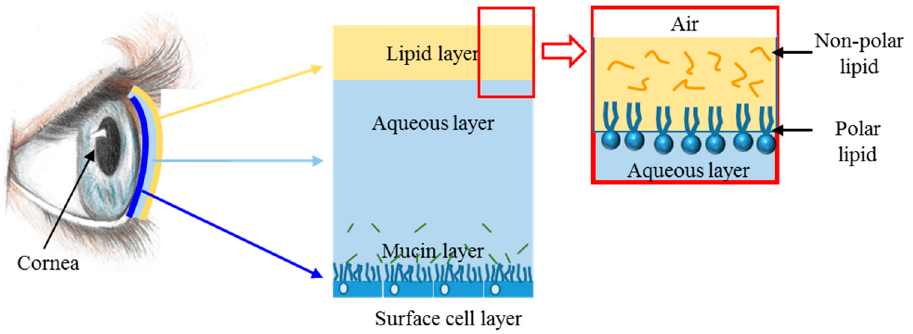
Figure 4. A scheme of the eye’s lipid layers.